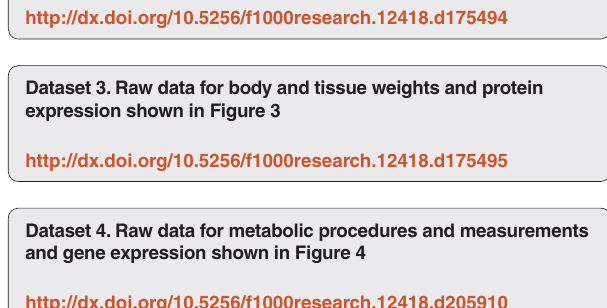
Dataset 4. Raw data for metabolic procedures and measurements and gene expression shown in Figure